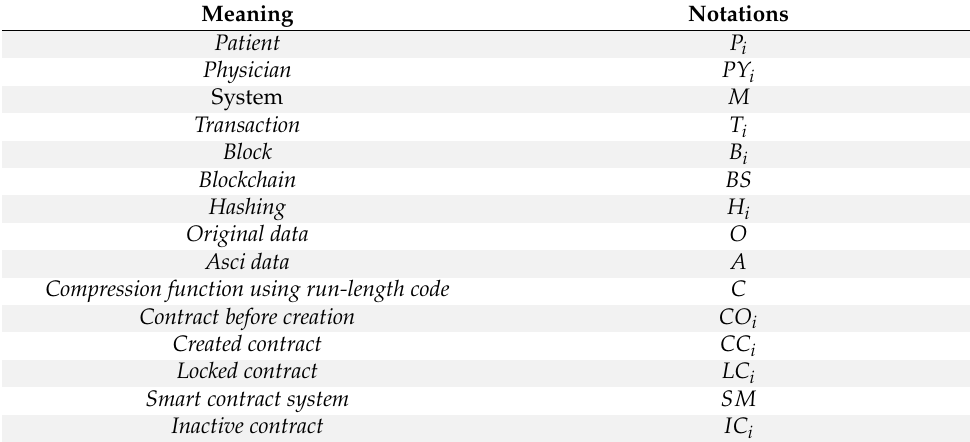
Table 3. Algorithm notations.